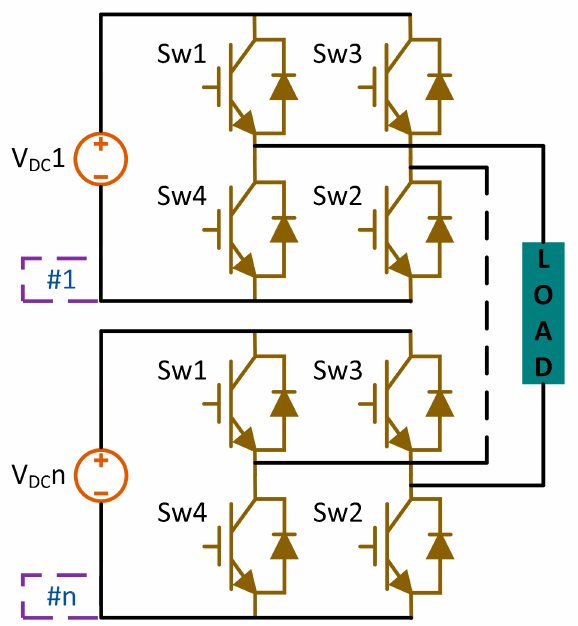
Figure 9. Topology of cascaded H-bridge multilevel